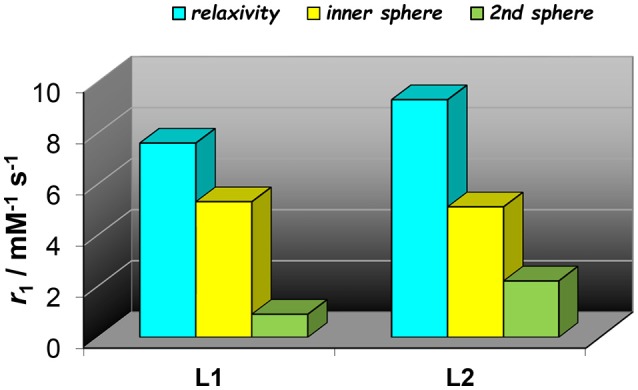
Comparison of proton relaxivities of Gd2L1 and Gd2L2 (298 K, 60 MHz) showing the inner- and second sphere contributions as analyzed with Model 2.